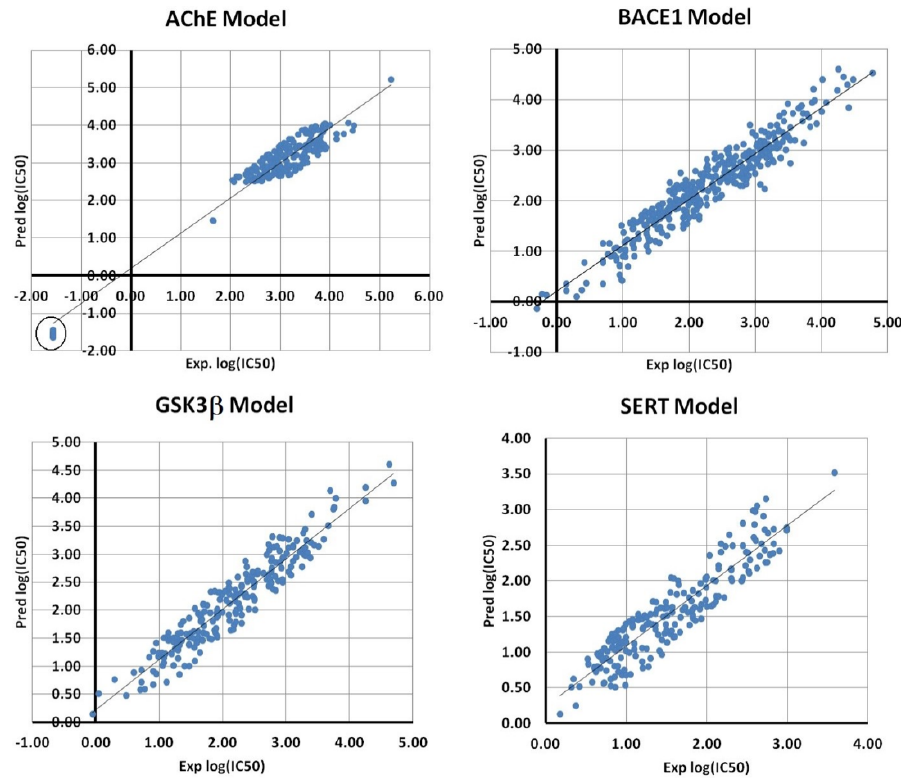
Figure 2. Scatter plots between experimental and predicted log (IC 50 ) values for all BMLR models.